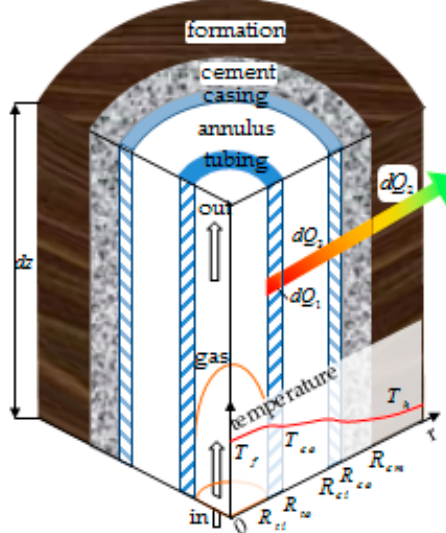
Figure 3. Schematic diagram of heat conduction through the radial Fig ure 3. Schematic diagram of heat conduction through the radial direction.